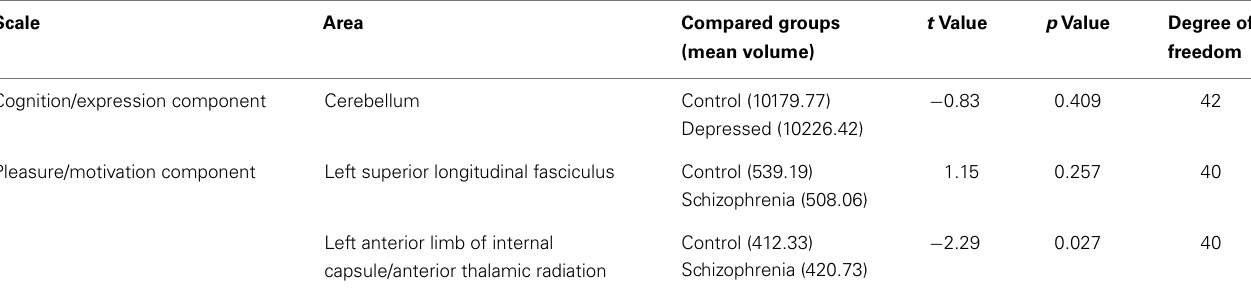
Table 4 | Differences between patients and controls in the extracted volumes of areas with significant relationships to the negative symptoms principal components, controlling with age, gender, and total gray or white-matter volume